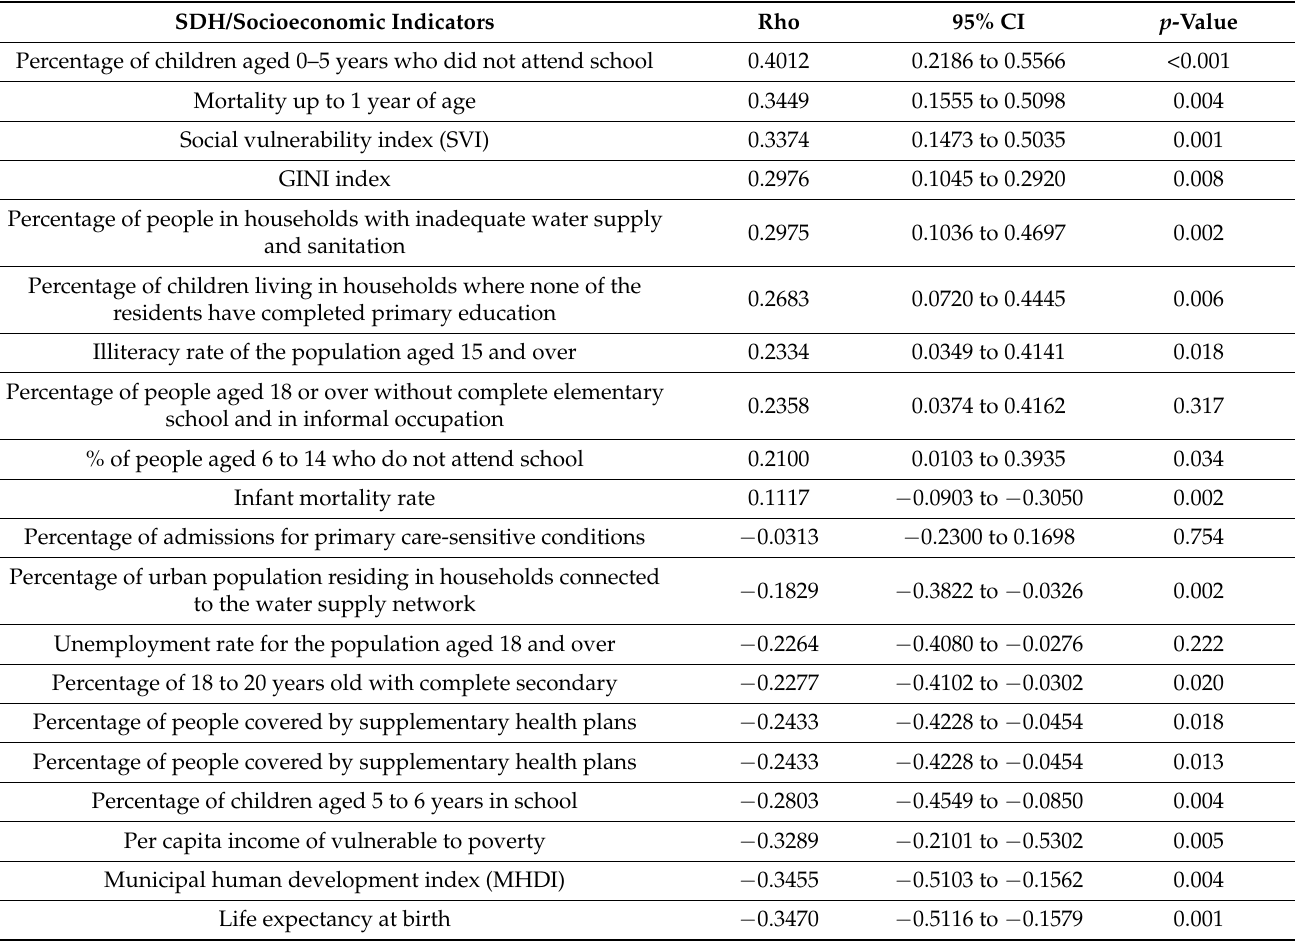
Table 4. Correlation between the mortality rate from diarrhea and infectious gastroenteritis and socioeconomic indicators of human development and social vulnerability in the municipalities of Alagoas, Northeast Brazil between 2000 and